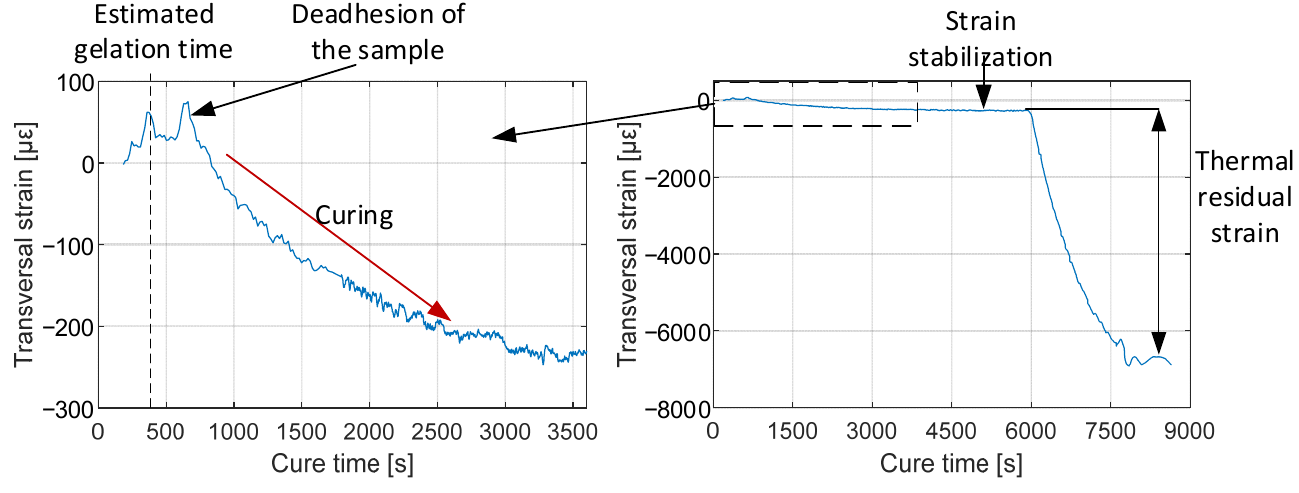
Figure 8. Through-thickness strain during manufacturing.